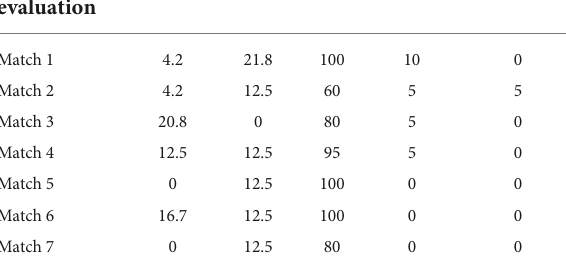
TABLE 1 Values in the POMS factors of Subject 1 after the